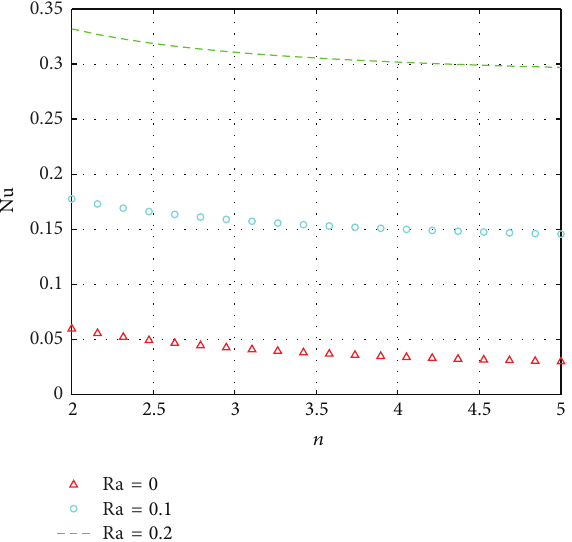
Figure 11: Variation of wall heat transfer with hematocrit shape; 𝑡 = 50 .